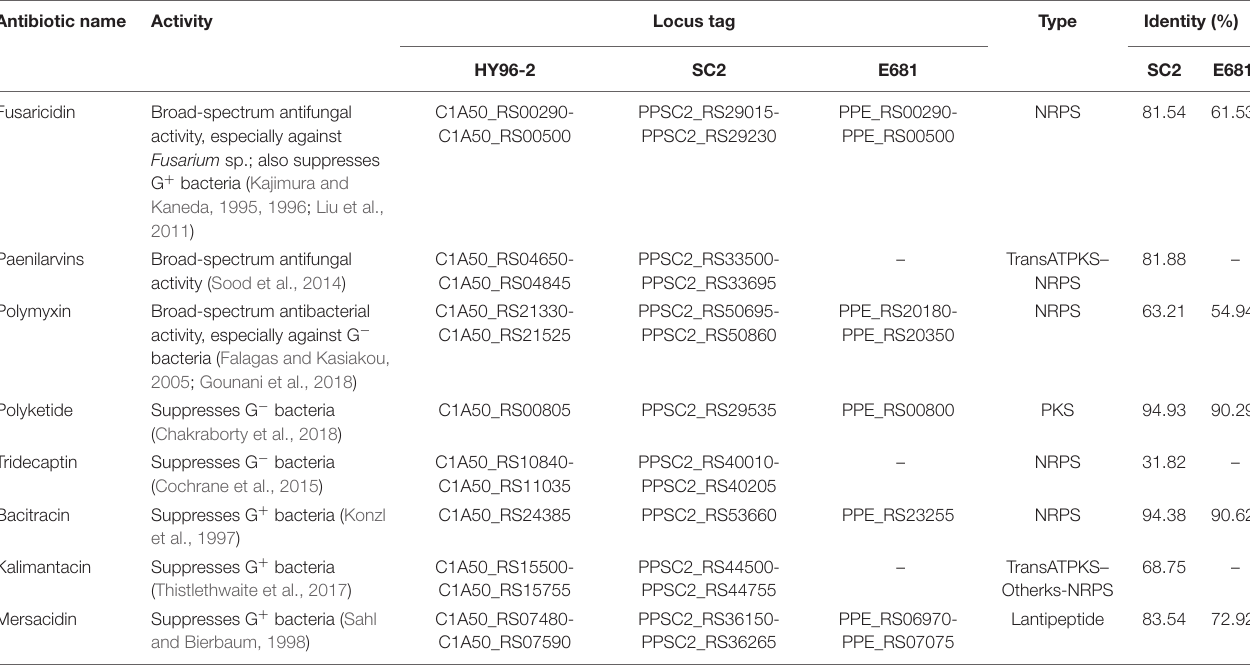
TABLE 4 | Comparison of gene clusters and core genes involved in antibiotic biosynthesis in strain HY96-2, as well as in strains SC2 and E681. Antibiotic name Activity